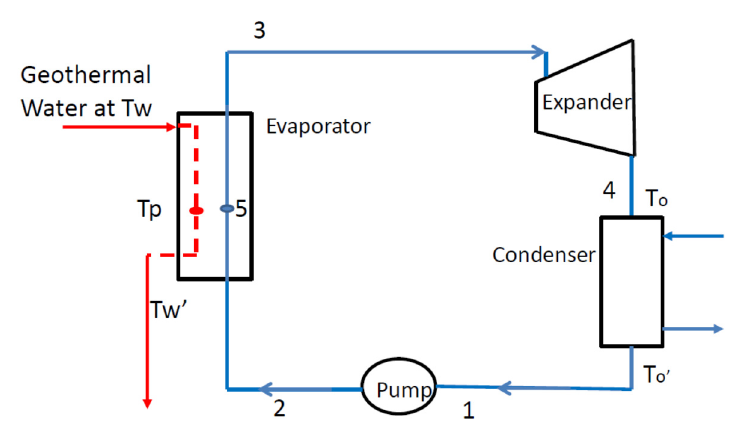
Figure 5. Schematic of a basic Rankine